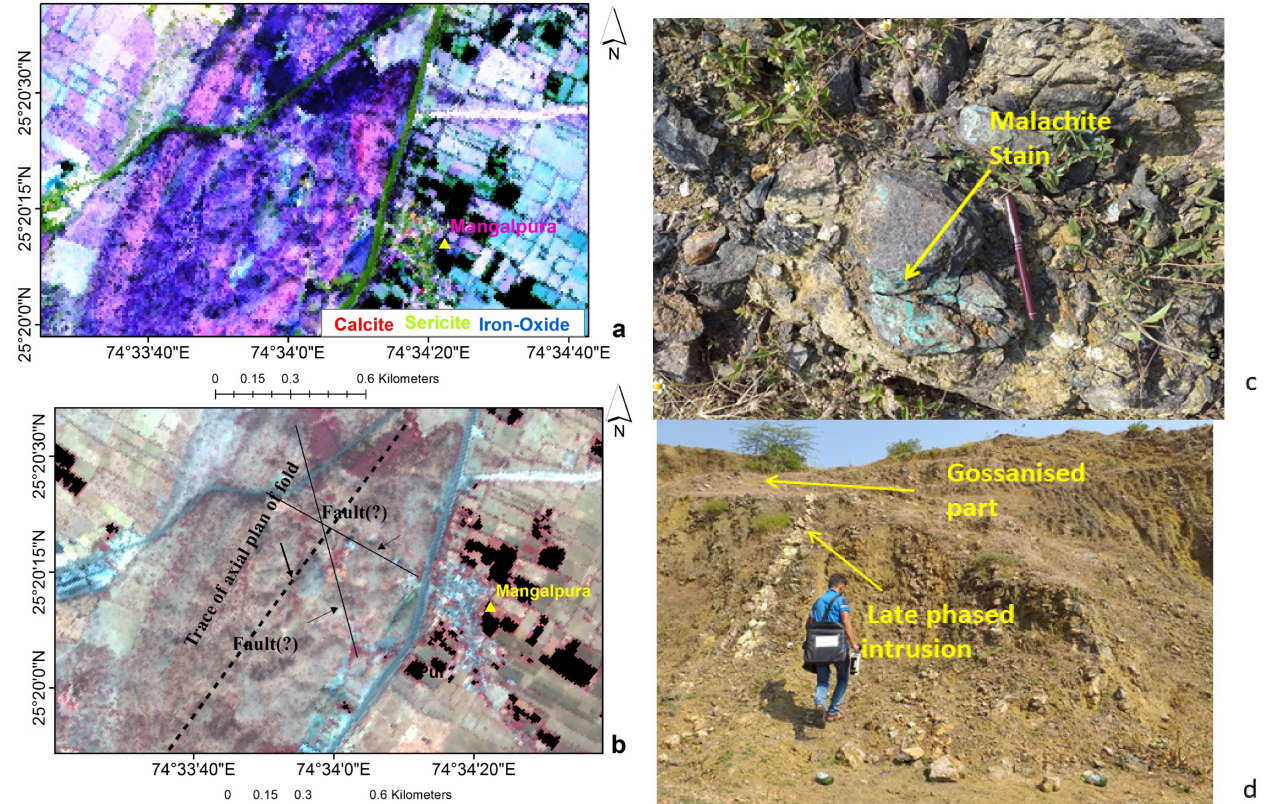
Figure 16. ( a ) False color image composite map of RBDs prepared for detecting calcite, sericite, and iron oxide are used to these minerals within BMQ around Mangalpur area. ( b ) FCC image composite of AVIRIS-NG bands are used to show localized geological structures. In the AVIRIS image, Red = 850 nm, Green = 650 nm, and Blue = 560 nm. ( c ) Malachite stains within BMQ were also identified during field validation. ( d ) Carbonate-rich sericitized veins were also identified in Mangalpura